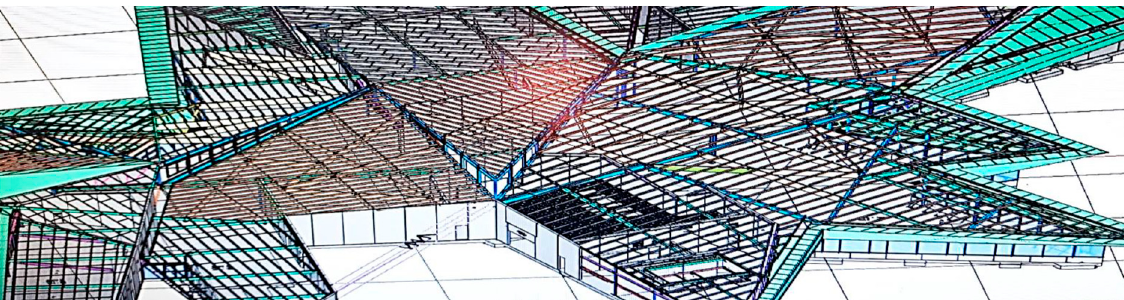
Figure 2. Steelwork and Precast Design of Builder C3 (Adapted from Phillip Island Nature Parks, 2022).